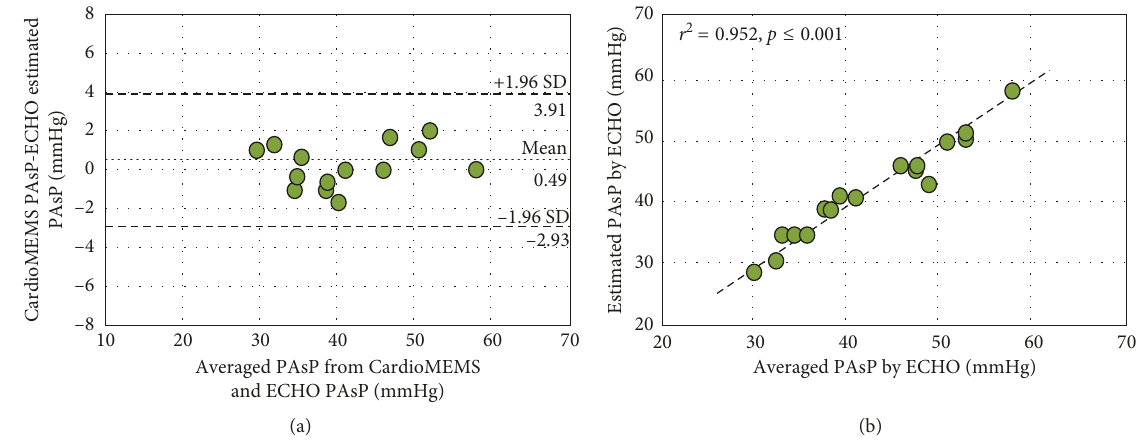
Figure 2: Bland–Altman analysis (a) and linear correlation (b) between CardioMEMS-derived pulmonary artery systolic pressure (PAsP) and echocardiography-estimated PAsP derived from tricuspid regurgitation jet